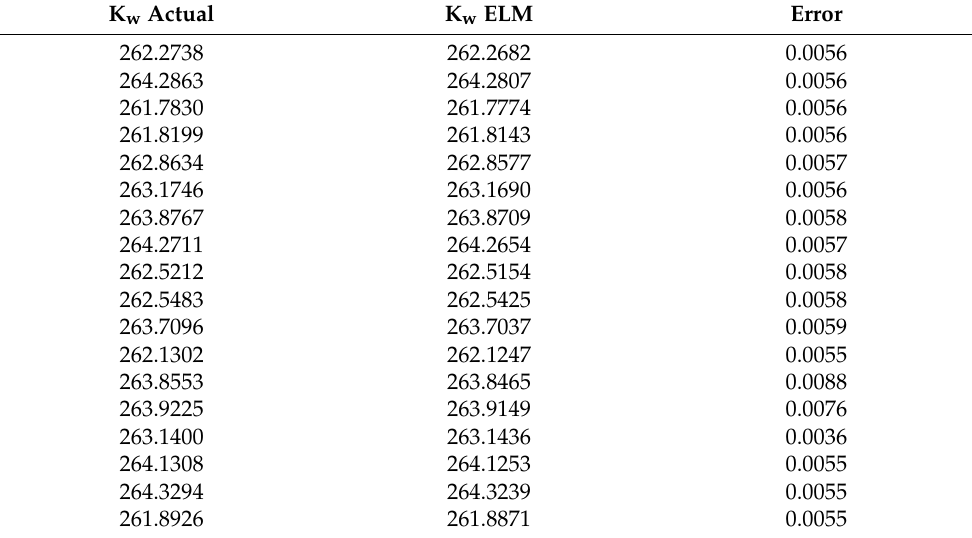
Table 3. Detailed features of the results are given in Figure 8.